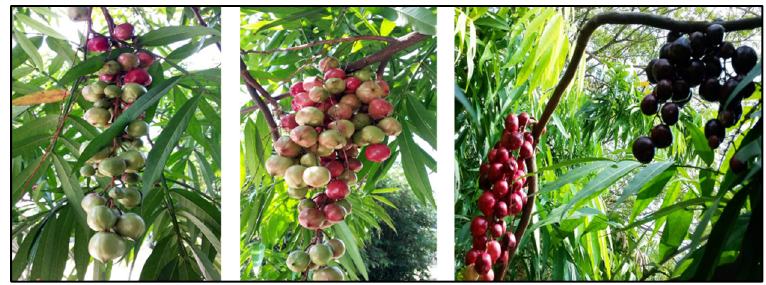
Figure 1. Lepisanthes alata .